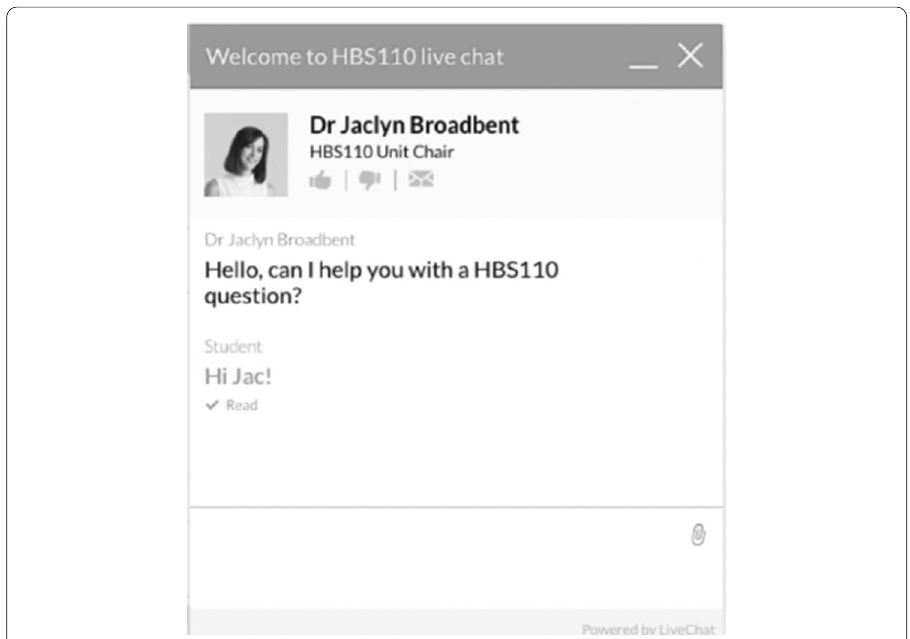
Fig. 1 Example of the LiveChat pop-up widget (student